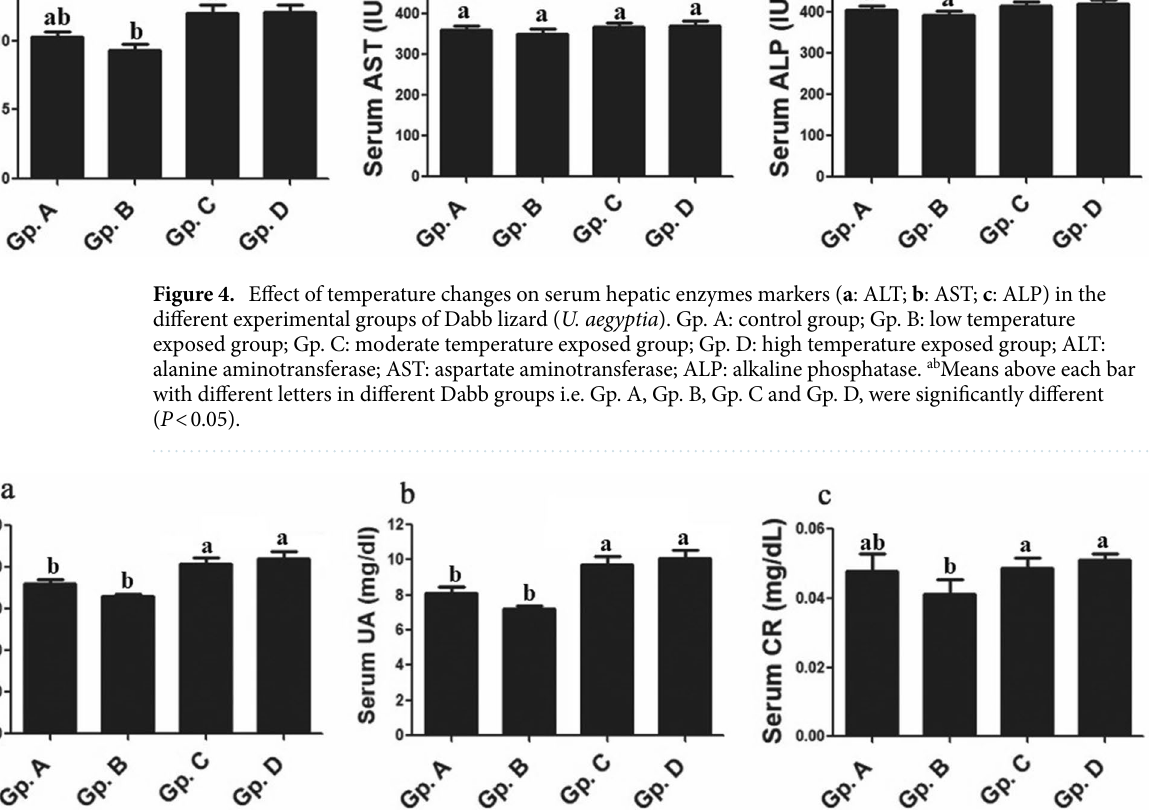
Figure 5. Effect of temperature changes on serum kidney function ( a : urea; b : UA; c : CR) in the different experimental groups of Dabb lizard ( U. aegyptia ). Gp. A: control group; Gp. B: low temperature exposed group; Gp. C: moderate temperature exposed group; Gp. D: high temperature exposed group; CR: creatinine; UA: uric acid. ab Means above each bar with different letters in different Dabb groups i.e. Gp. A, Gp. B, Gp. C and Gp. D, were significantly different ( P < 0.05).